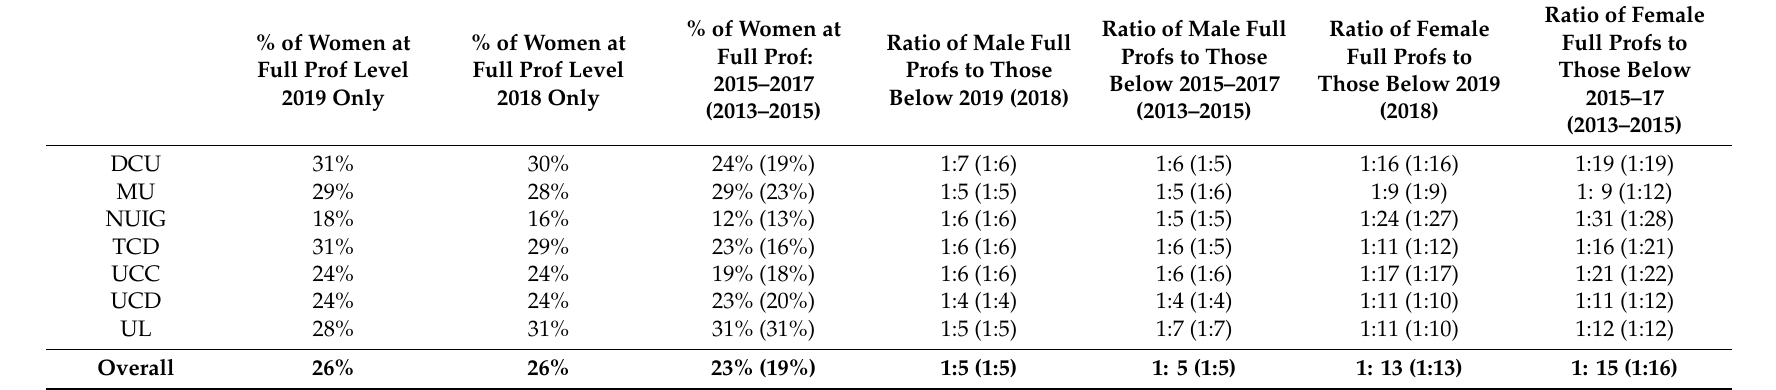
Table 2. Percentage of women at full professorial level in Irish universities 2019; 2018; 2015–2017; 2013–Dec * and ratio of male and female professors to those below (rounded to whole